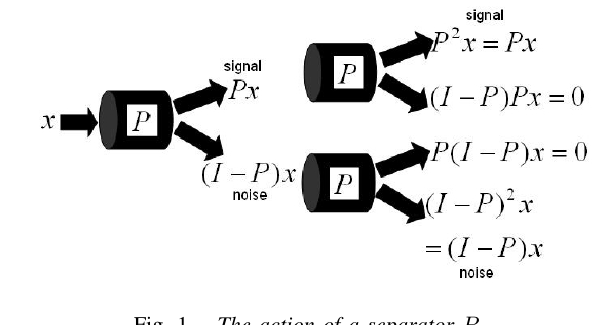
Fig. 1. The action of a separator